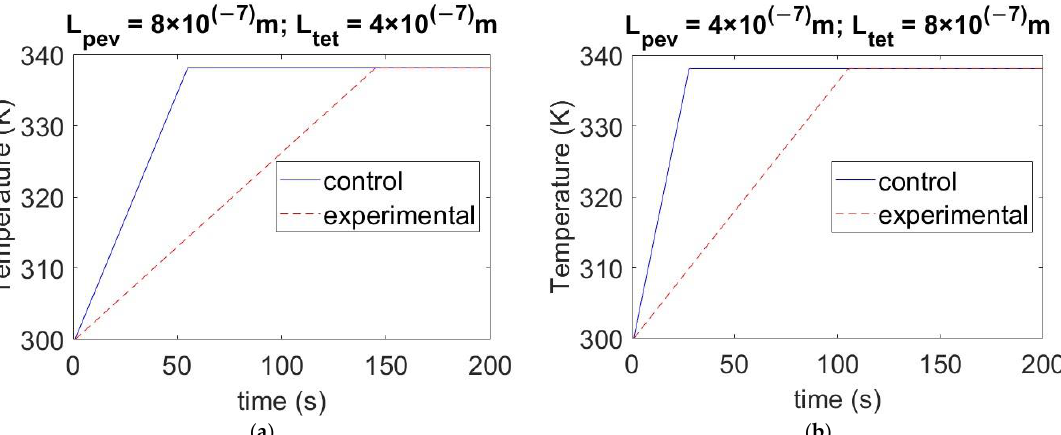
Figure 7. The temperature of the perovskite layer in the control and experimental case with ( a ) The thickness of the perovskite layer is twice the reference value ( b ) The thickness of the tetracene layer is twice the reference value.